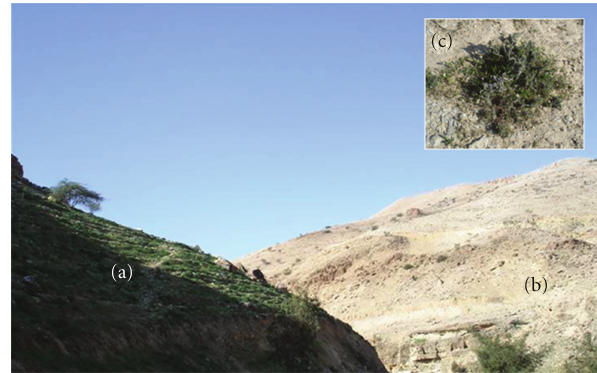
Figure 3: View of a North- (a) and a South- (b) facing slope of Wadi Shuayb, Jordan. The North-facing slope corresponds to a core habitat for many annual (low stature) species and the South-facing slope to a mosaic of marginal habitats with patches of mild habitats created by benefactors (Box 1). (c) Facilitation by the benefactor Gymnocarpos decanter of annual vegetation on the South-facing